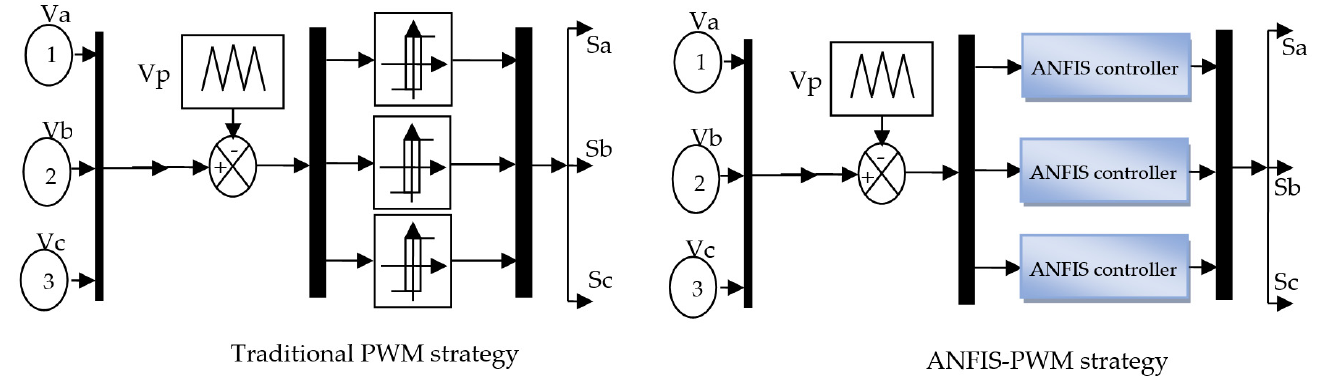
Figure 3. Structure of the traditional PWM strategy ( left ) and proposed IPWM strategy ( right ).